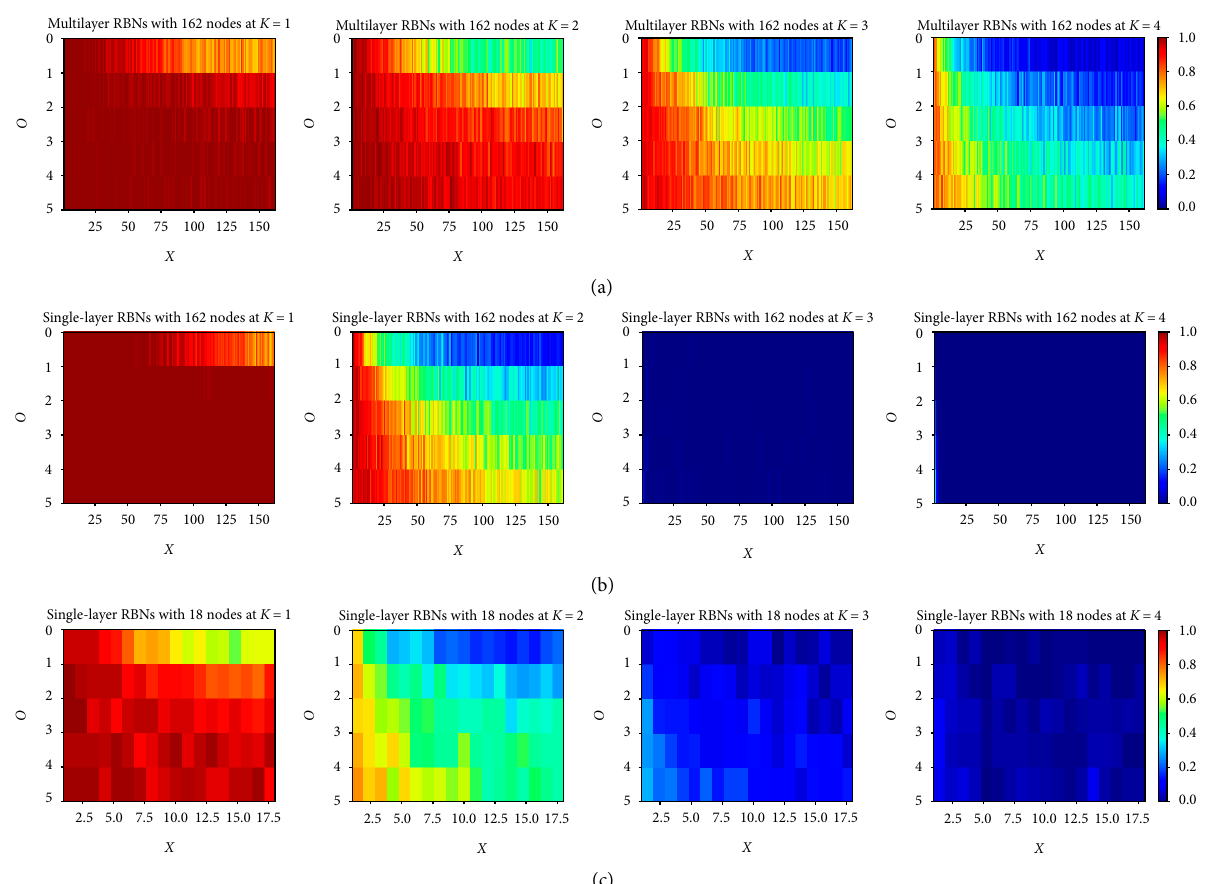
Figure 6: Probability of generating antifragile networks depending on 𝑋 and 𝑂 for 𝐾 = 1, 2, 3, 4 (from left toward right). The probability is between 0 and 1. In the color bar, blue represents the minimum probability, and red means the maximum value. (a) Probability of producing ). (b) Probability of producing antifragile networks in single‐layer networks ( 𝑁 antifragile networks in multilayer networks ( 𝑁 𝑇 = 162 with the same state space size as multilayer networks. (c) Probability of producing antifragile networks in single‐layer networks ( 𝑁 the same node size as the number of genes in one cell of the multilayer network model.